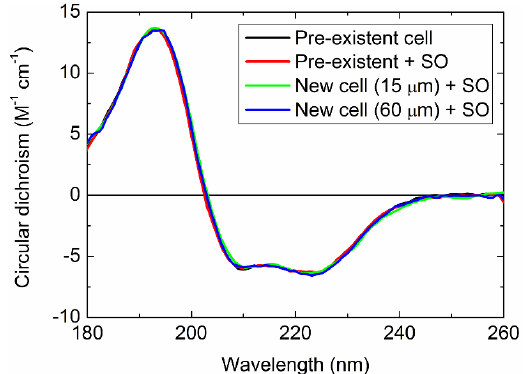
Figure 6. CD spectra of myoglobin measured using the pre-existent cell (black), pre-existent cell and SO (red), new cell (15 μm path length) and SO (green), and new cell (60 μm path length) and SO (blue).